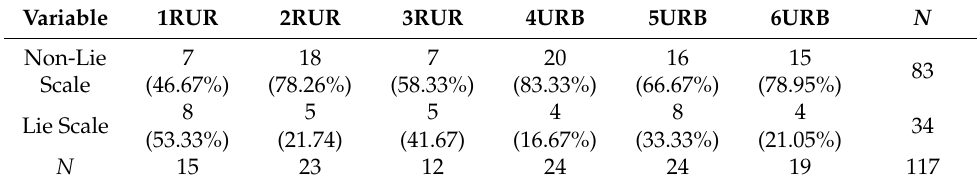
Table 4. Percentage of lie scale group and non lie scale group regarding group